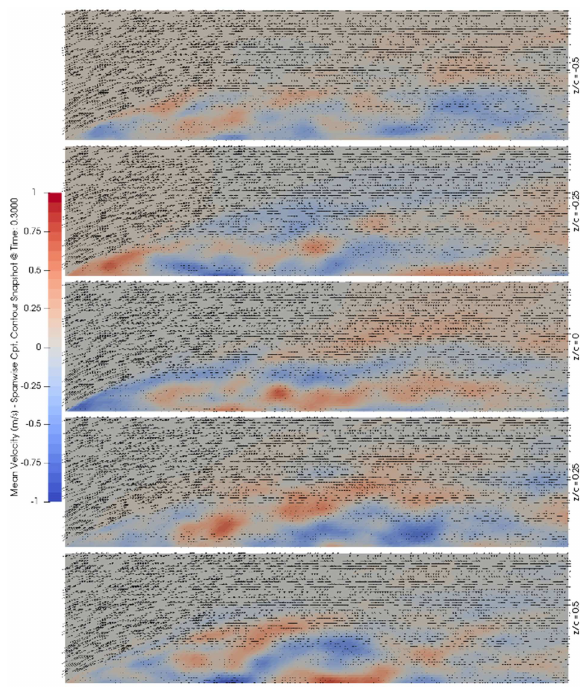
Fig. 6 . Spanwise normal planes above plate suction surface. Mean spanwise velocity contours and vectors of mean in-plane velocity.